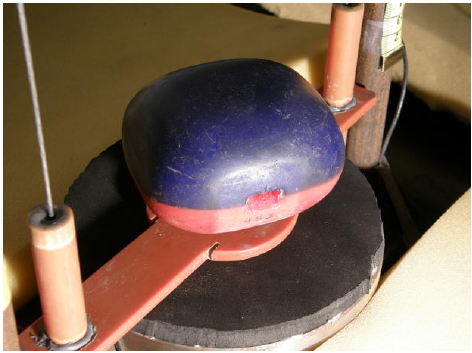
Figure 2. IRD on the sliding carriage of the drop simulator (Section